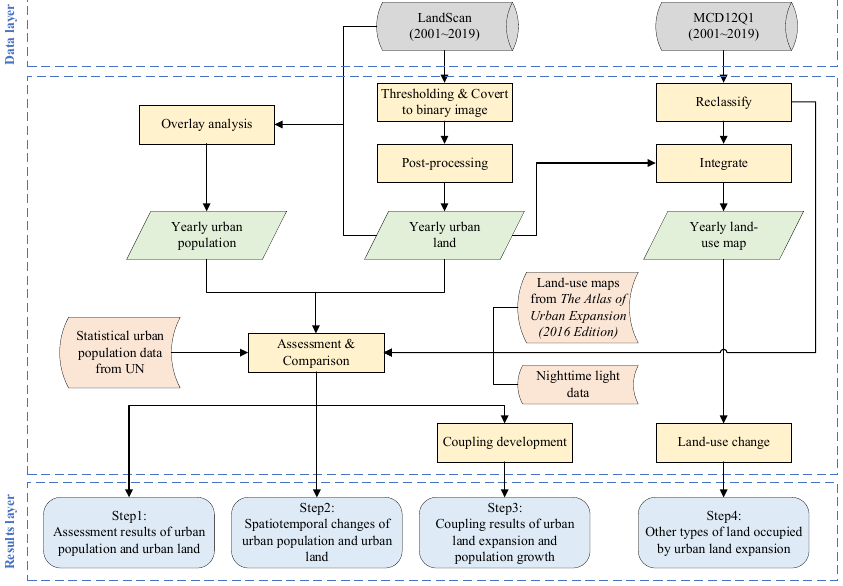
Figure 2. The flowchart and technical framework of the study.